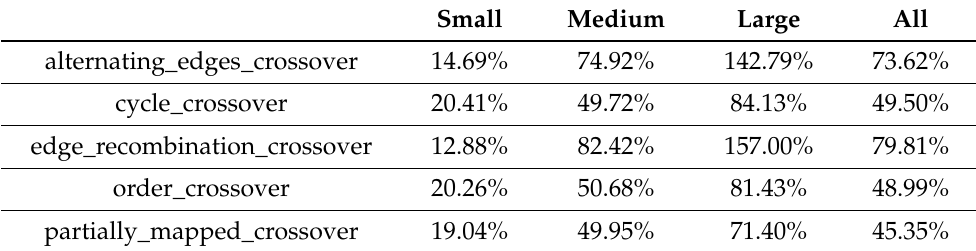
Table 3. All combinations, moderate settings, fast experiment—averaged results for small, medium, large, and all instances, grouped by crossover